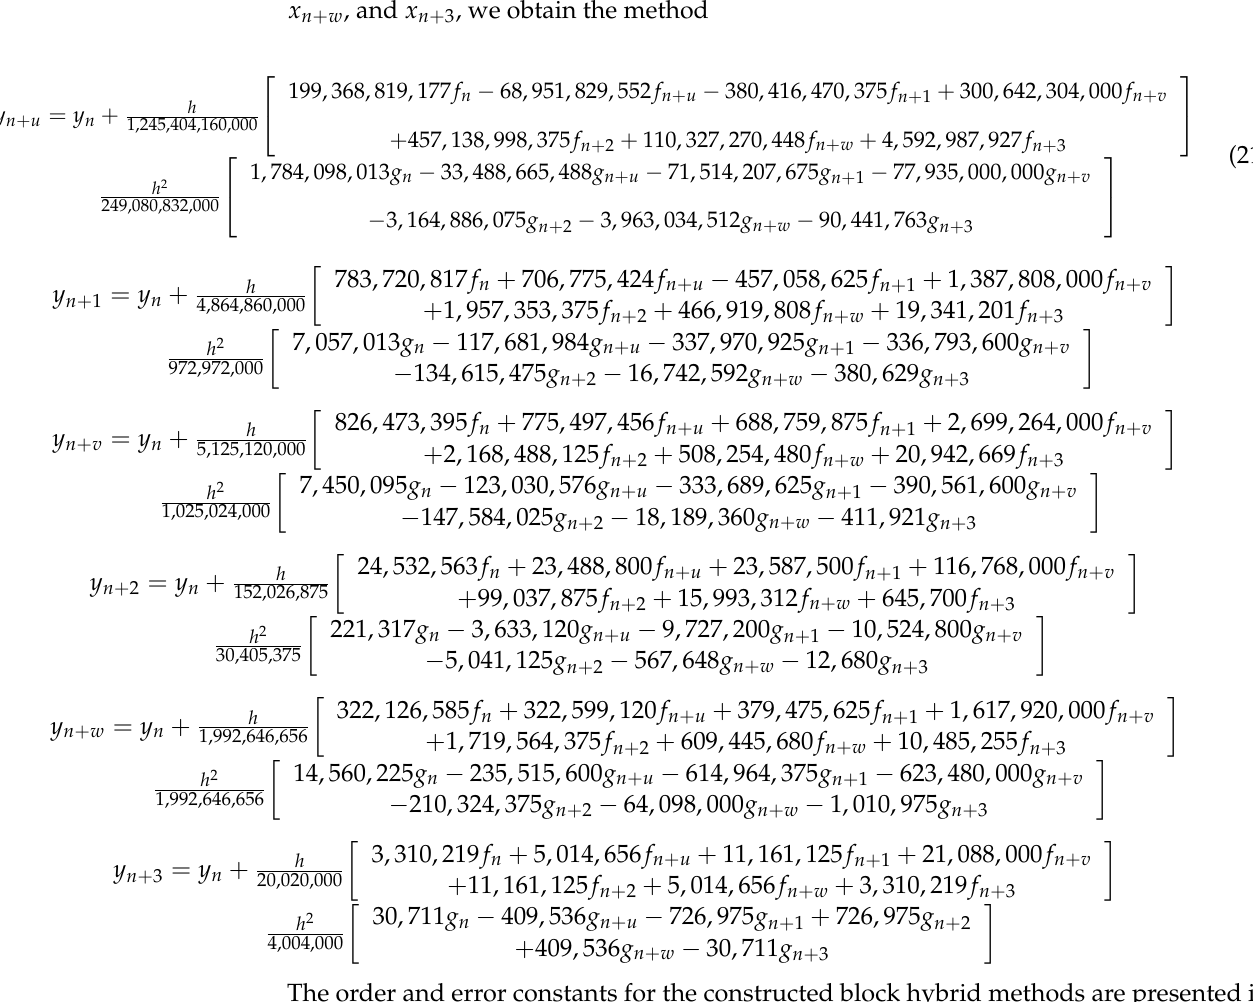
second-derivative evaluation are all of order seven except the last member in the